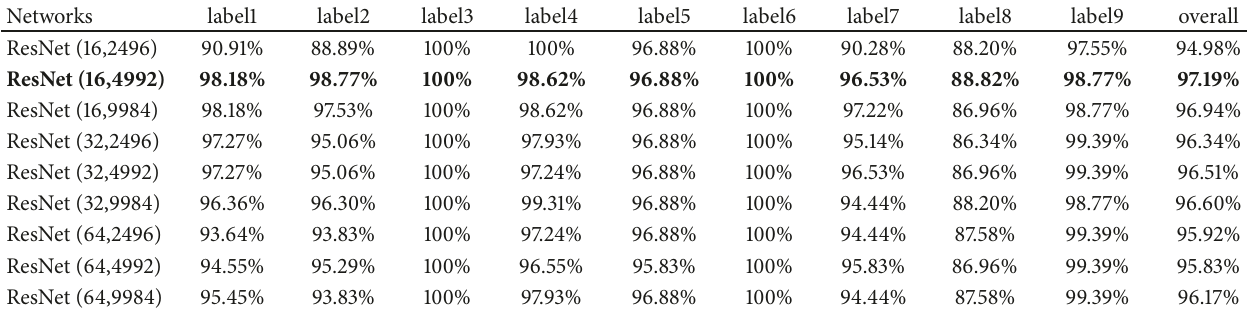
Table 4: Classification accuracies with different parameters during fine-tuning of the ResNet. The numbers inside parenthesis indicate batch size and number of iterations.